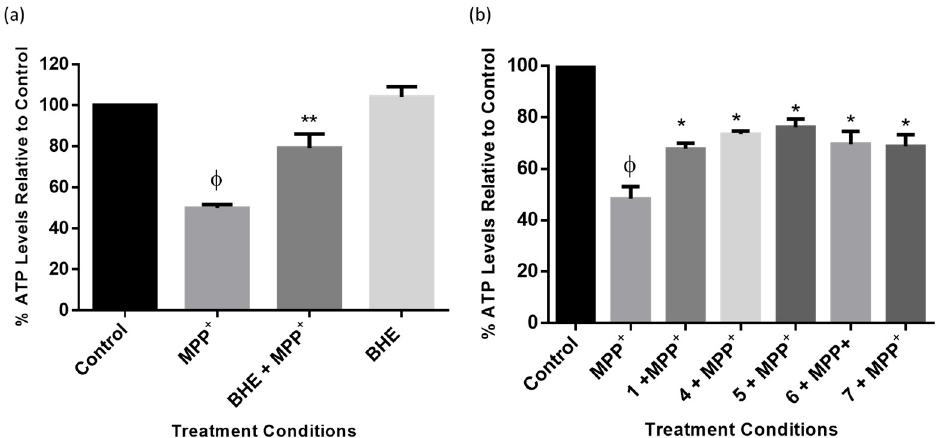
Figure 9. BHE and compounds inhibit MPP + -induced ATP degeneration. Cells were pre-treated with 2.5 µg/mL of extracts ( a ) and compounds ( b ) before exposure to 2000 µM of MPP + for 24 h and ATP level assessment. Each bar represents mean percentage level relative to control, and significance of difference indicated with * ( p < 0.05) and ** ( p < 0.01) when extract/compounds are compared to MPP + and φ (MPP + vs. control).